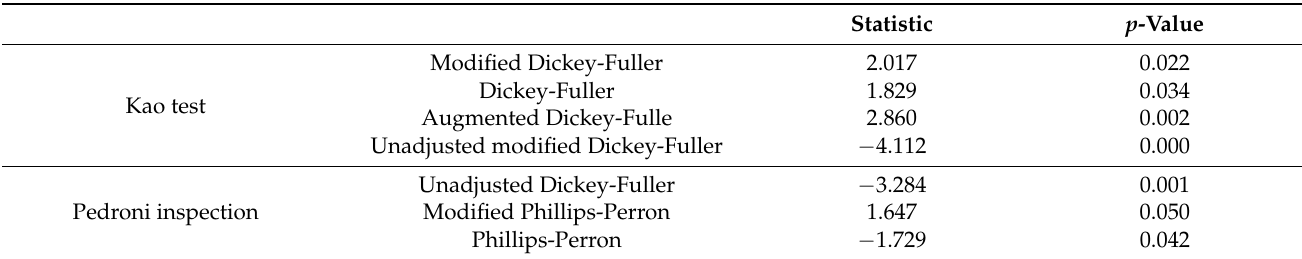
Table 8. Kao Test and Pedroni Test